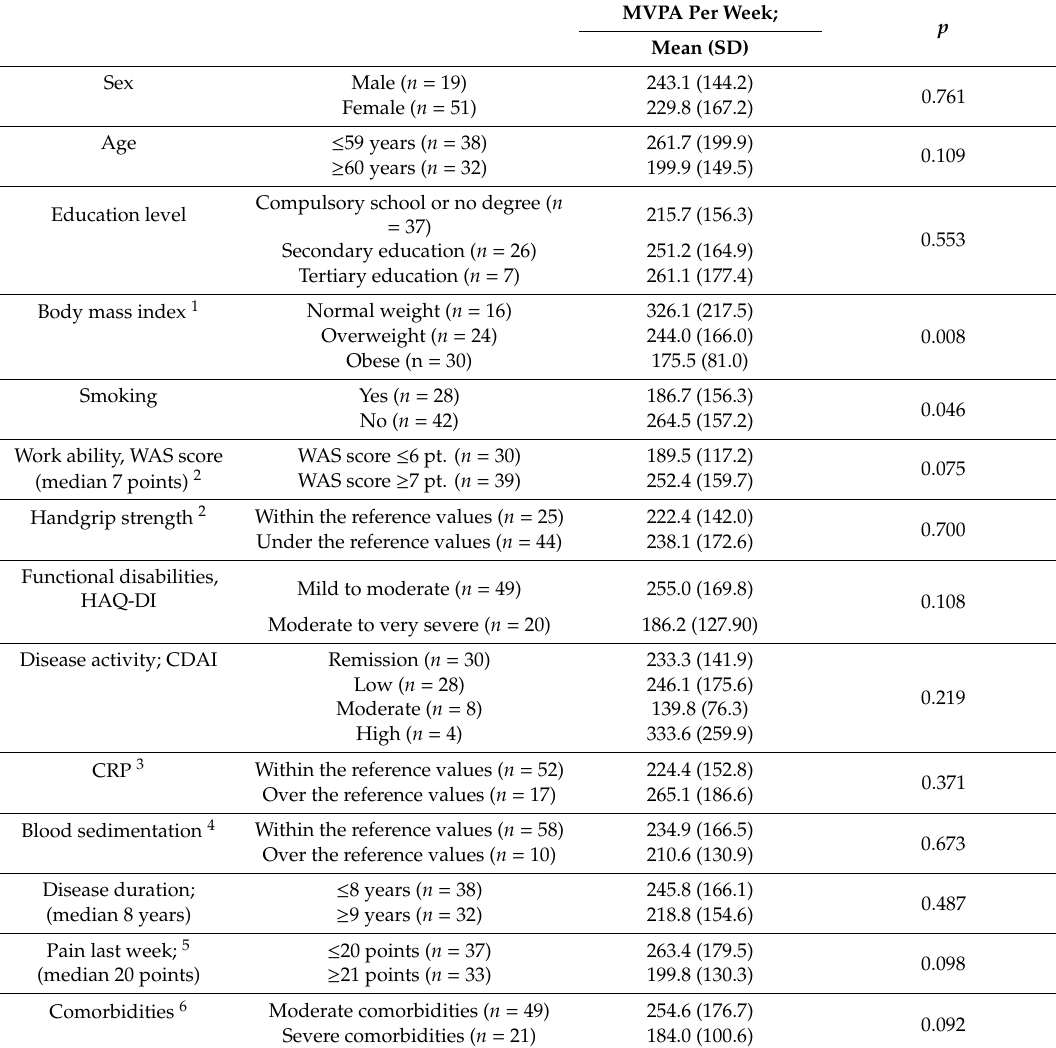
Table 3. Comparison of the mean values for time (min) spent in moderate and vigorous physical activity (MVPA) in